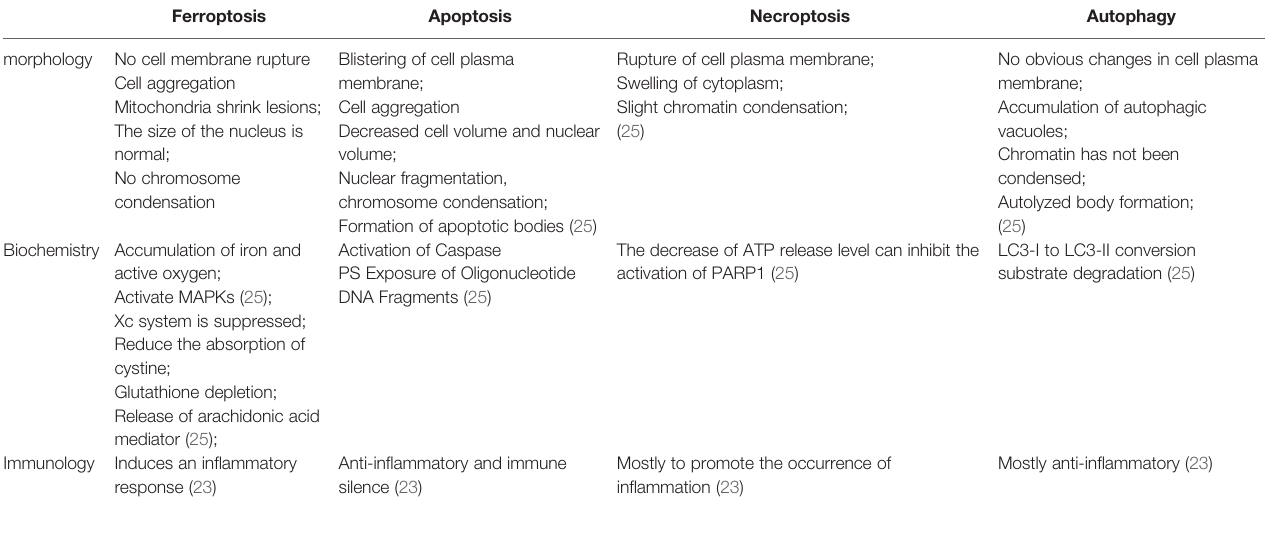
TABLE 2 | Comparison of differences among Ferroptosis, apoptosis, necroptosis, and